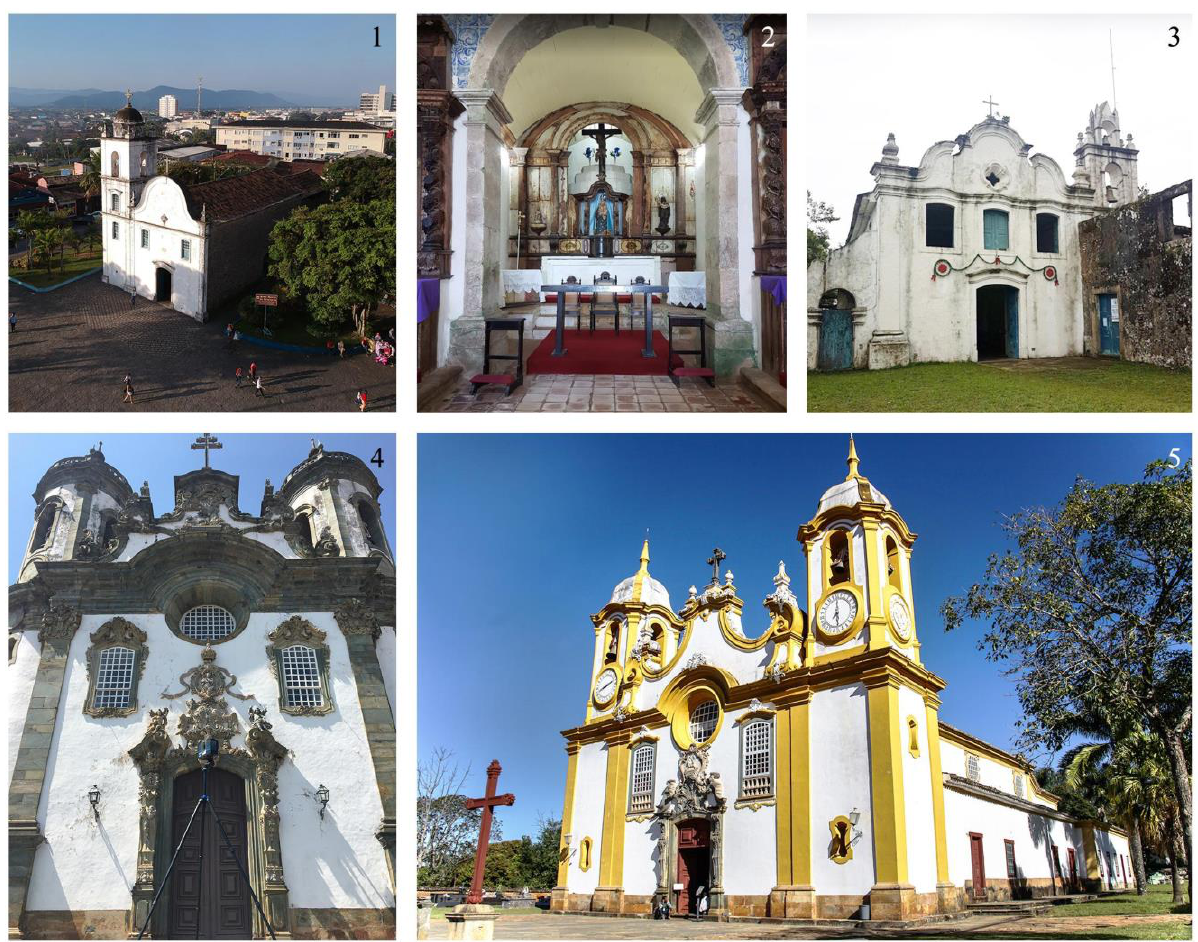
Figure 2. Examples of Heritage colonial religious Building: (clockwise) Sant’Anna Church, the interior and exterior of the Convent of Nossa Senhora in Itanhaem, the facade of San Francesco d’Assisi in Sao Joao del Rei and Igreja Matriz de Santo Antonio in